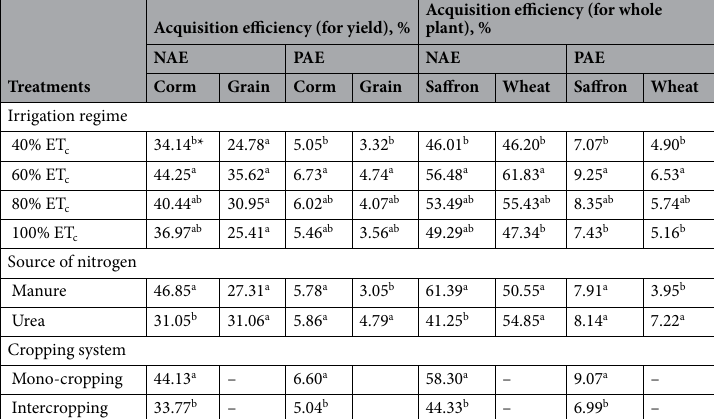
Table 9. Means for nitrogen and phosphorus acquisition efficiencies (NAE and PAE, respectively) for yield (corm or grain) and the whole plant (saffron and wheat), all for the last (fourth) growing season. *Means followed by similar letters in each column for each factor and each trait are not significantly different at 5% level of probability according to Tukey test.